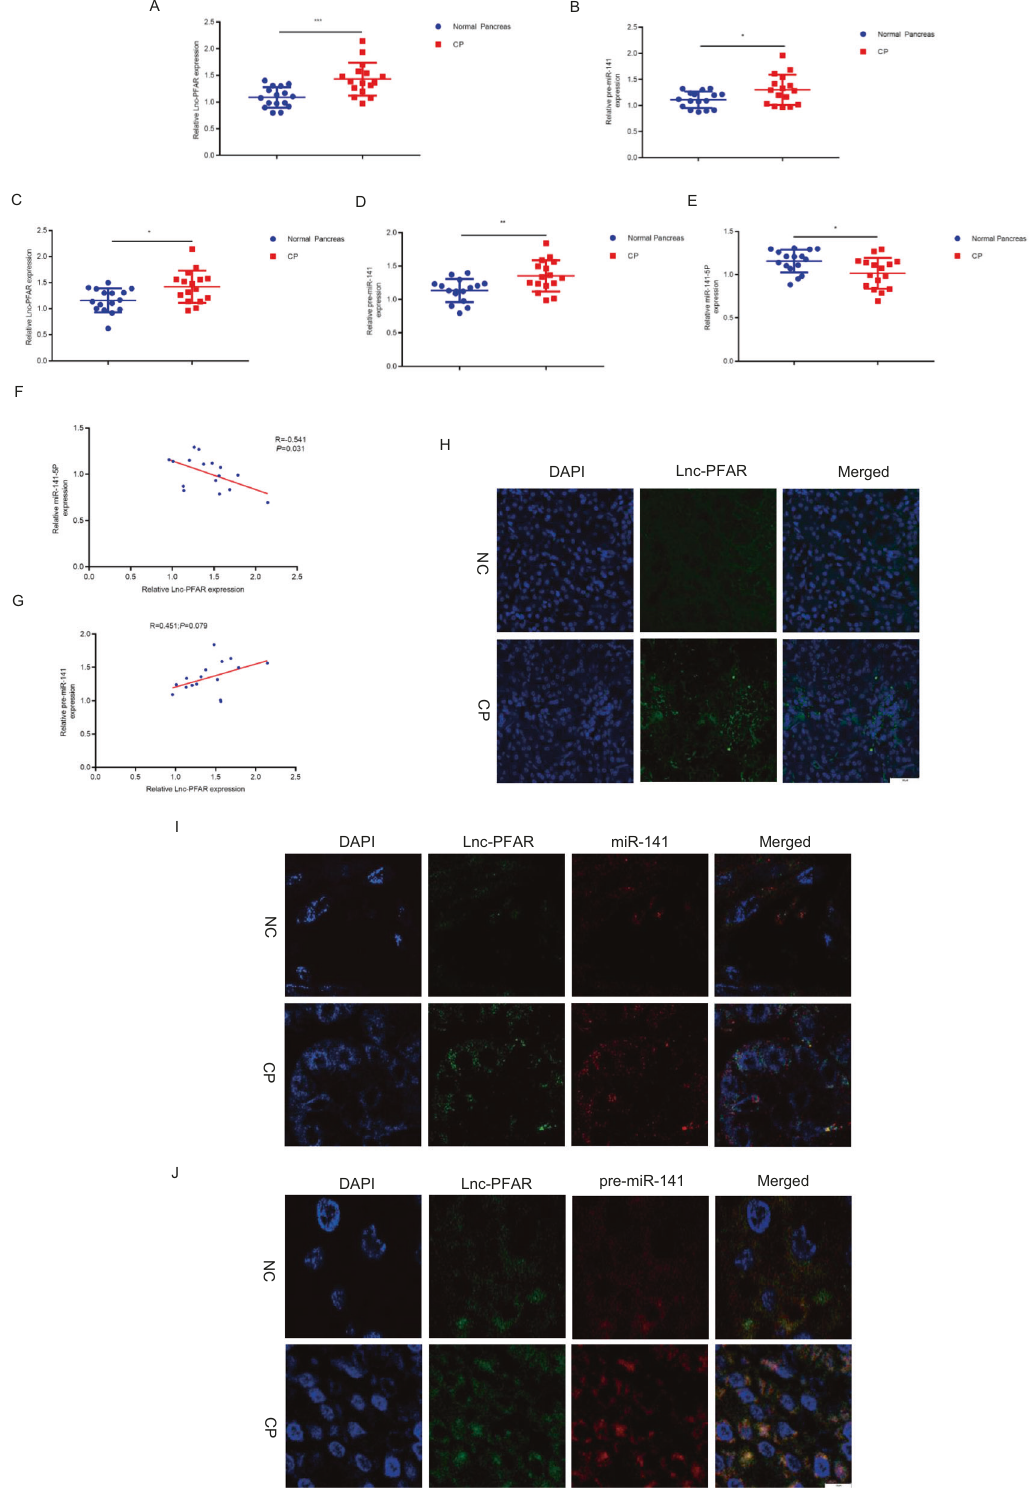
Fig. 6 Lnc-PFAR expression was correlated with pancreatic fi brosis in CP patients. A , B The expression levels of lnc-PFAR and pre-miR-141 were explored in human normal pancreas and CP tissues. C – E The expression levels of lnc-PFAR, pre-miR-141, and miR-141-5P were measured in the plasma of healthy volunteers and CP patients. F , G The correlations among Lnc-PFAR, pre-miR-141, and miR-141-5P expression levels were explored in the plasma of healthy volunteers and CP patients. H FISH assay showed that Lnc-PFAR was predominantly localized in the cytoplasm. I FISH assay demonstrated that miR-141 and Lnc-PFAR were mutually exclusive in the cytoplasm in the normal pancreas and CP tissues. J FISH assay indicated the co-localization between Lnc-PFAR and pre-miR-141 in normal pancreas and CP tissues(bars, 50 μ